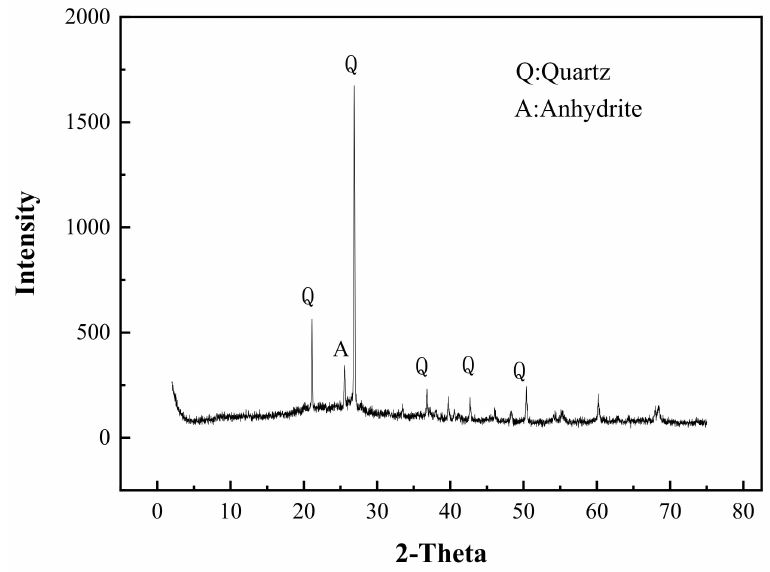
Figure 1. XRD pattern of coal fly ash